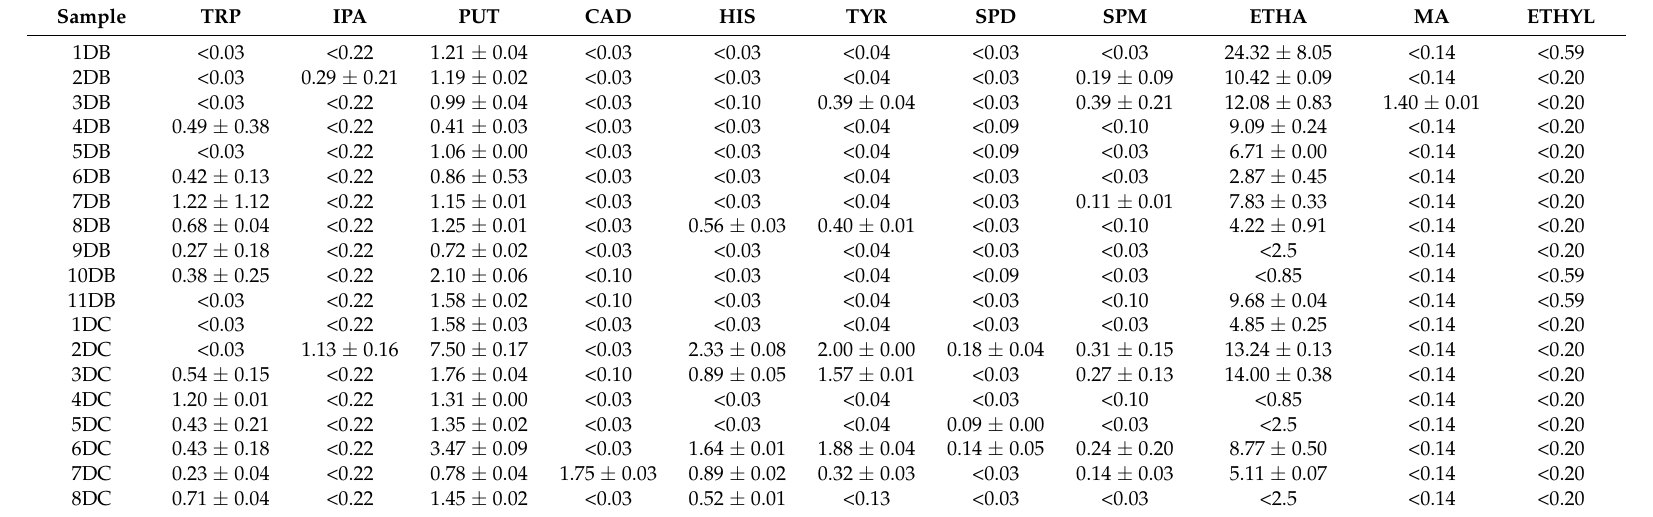
Table 5. The content of biogenic amines (mg L − 1 ) in 48 investigated wine